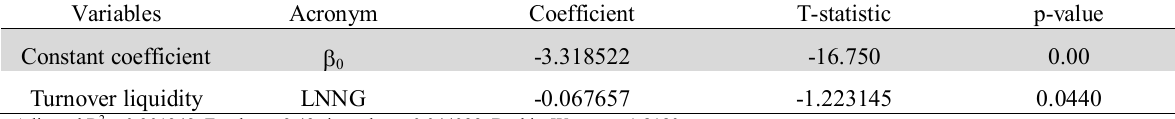
Regression estimation for the relationship between dividend policy and turnover liquidity Variables